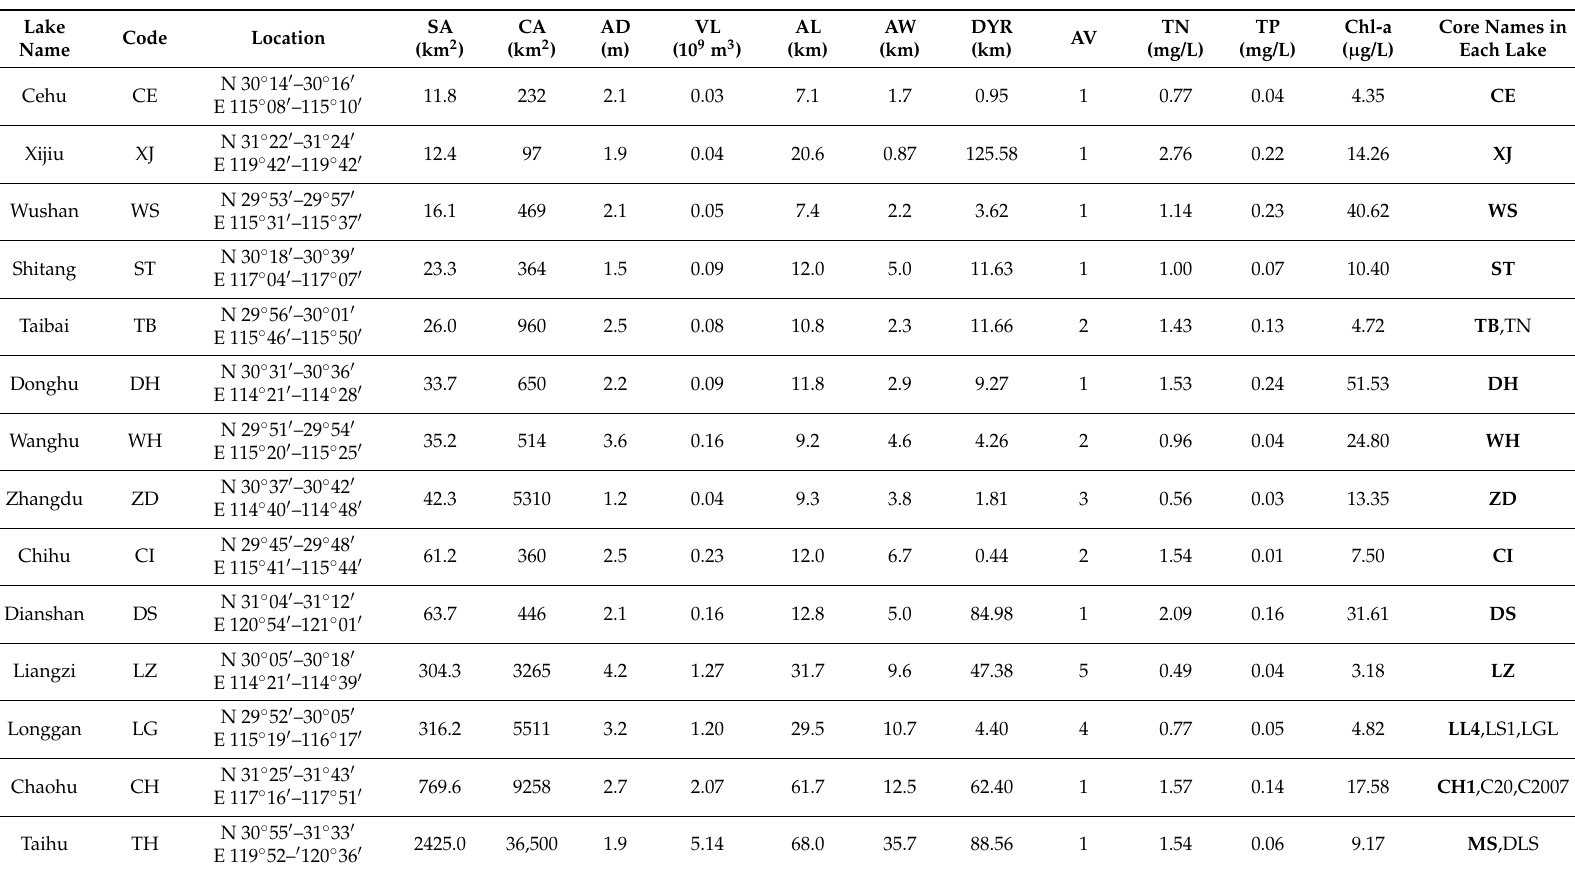
Table 1. Morphological features of the 14 study